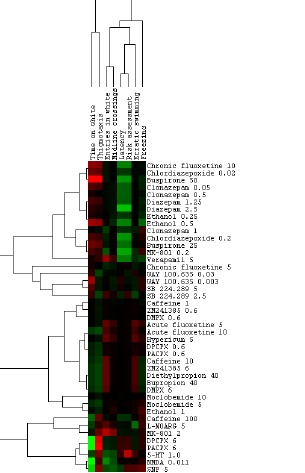
Figure 1. Behavioral fingerprint of selected drugs on the scototaxis test. Pharmacological manipulations were hierarchically clustered to link compounds to behaviors. In the clustergram, each cell represents the Maximum Predictive Value (red – higher than controls; green – lower than controls).